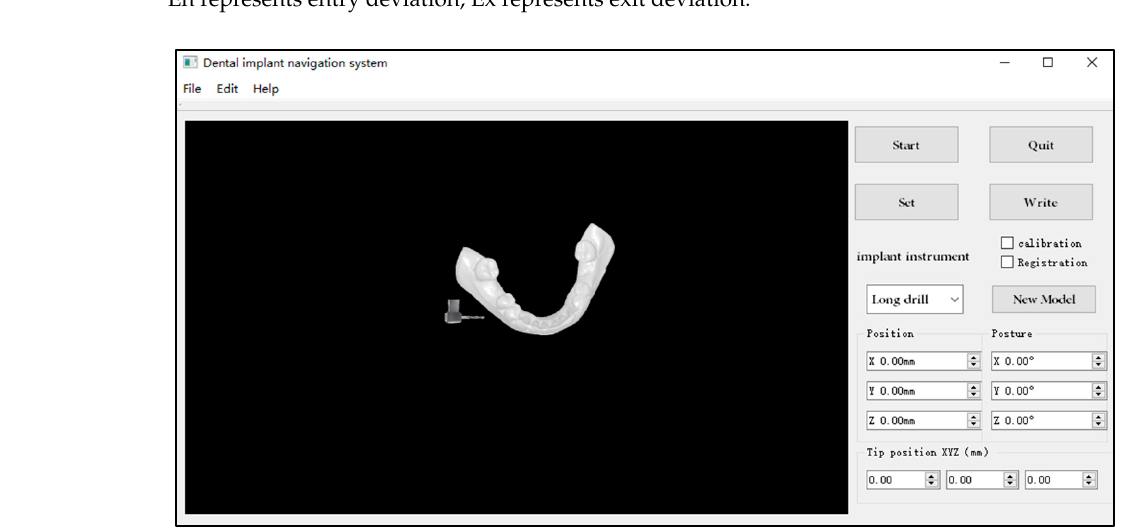
Figure 9. Image data processing. ( a ) Ideal implant is designed, ( b ) positioning markers are extracted, ( c ) comparison between the actual trajectory and the planned trajectory, An represents angle deviation, En represents entry deviation, Ex represents exit deviation.